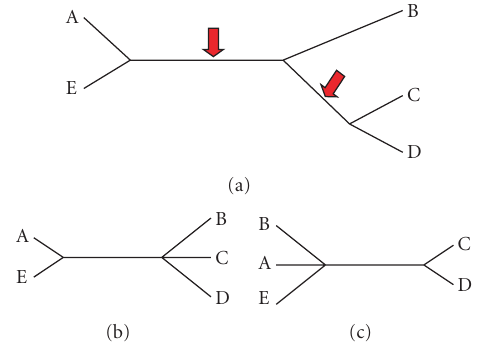
Figure 1: (a) An unrooted tree with 5 taxa, (b) the bipartition cor- responding to the left arrow above, (c) the bipartition correspond- ing to the right arrow above.